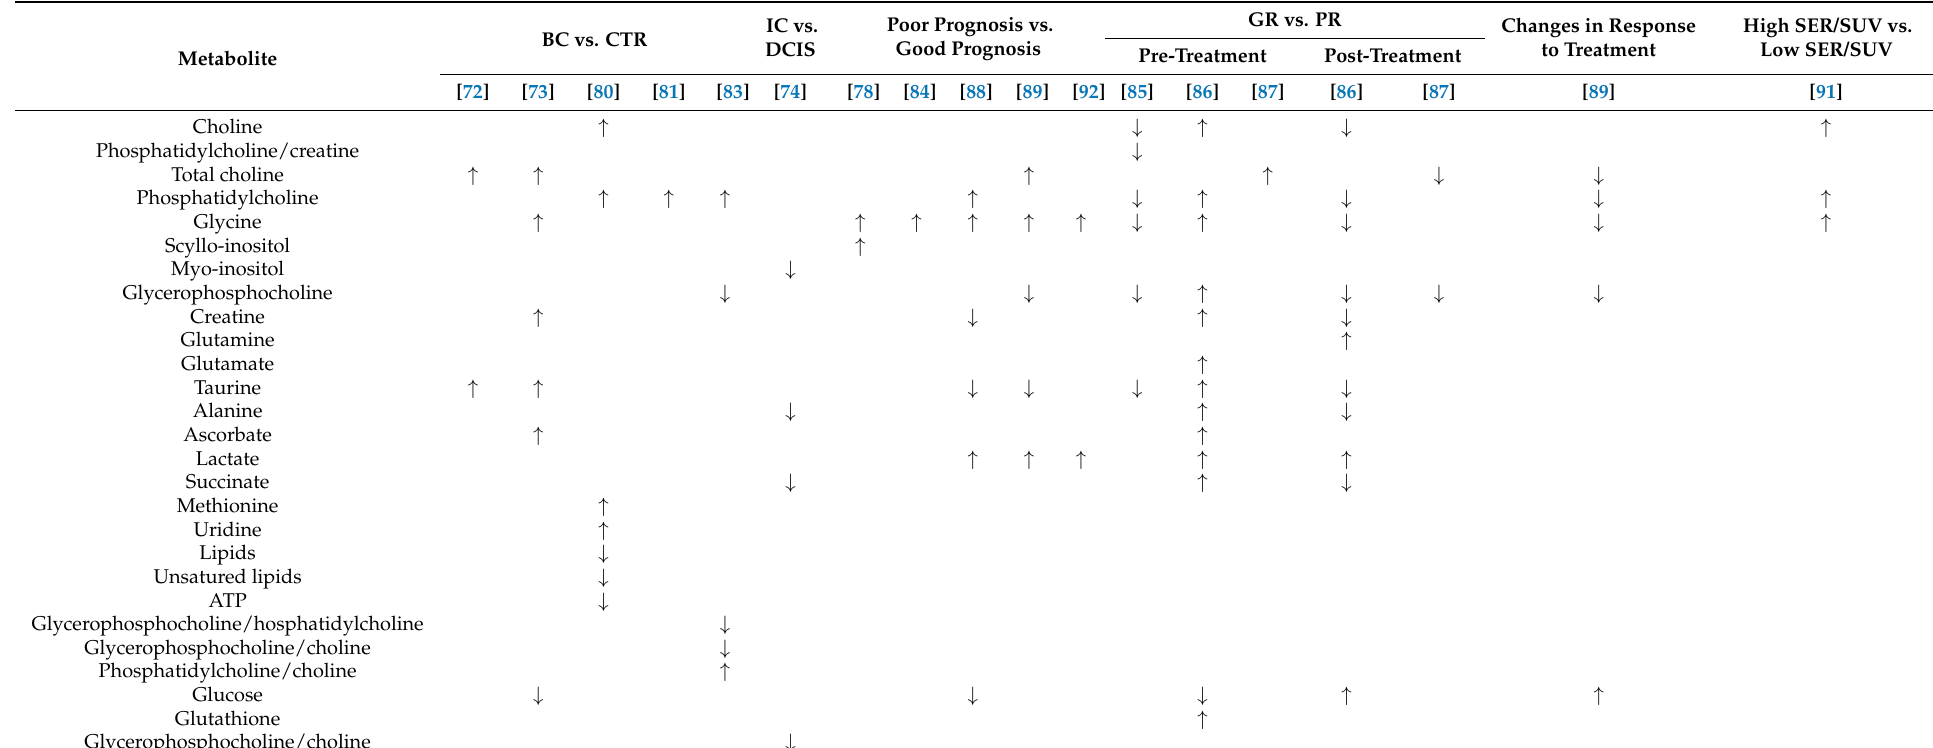
Table 2. List of altered metabolite levels identified in breast tissue of breast cancer patients to study their metabolomic profiles.